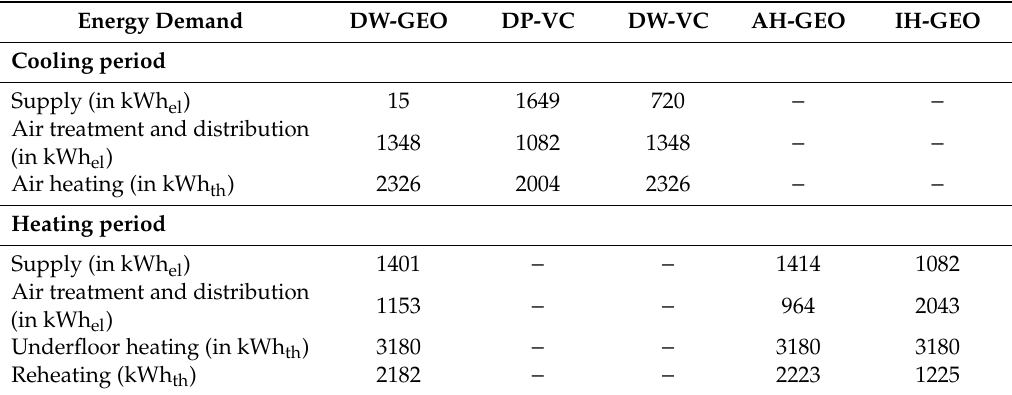
Table 5. Electrical and thermal energy demands for system